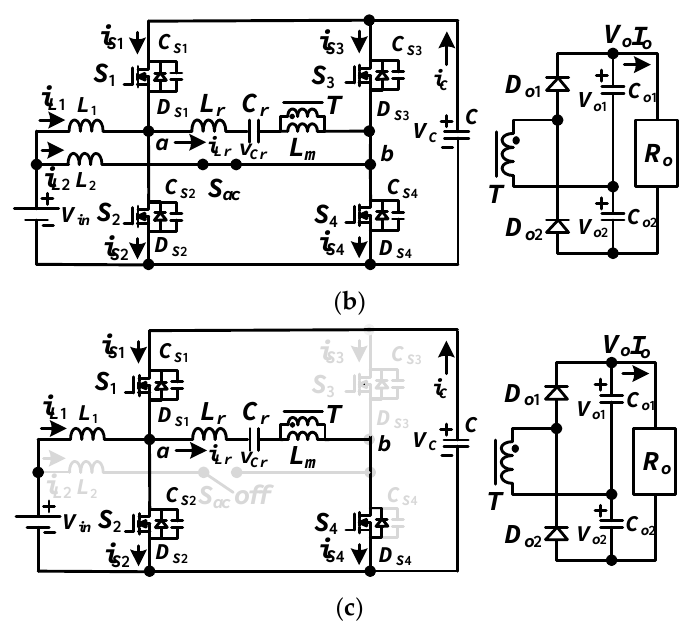
Figure 1. Proposed wide voltage range LLC (inductor–inductor–capacitor) converter with input current ripple-free ( a ) circuit diagram, ( b ) equivalent circuit under low input voltage mode, ( c ) equivalent circuit under high input voltage